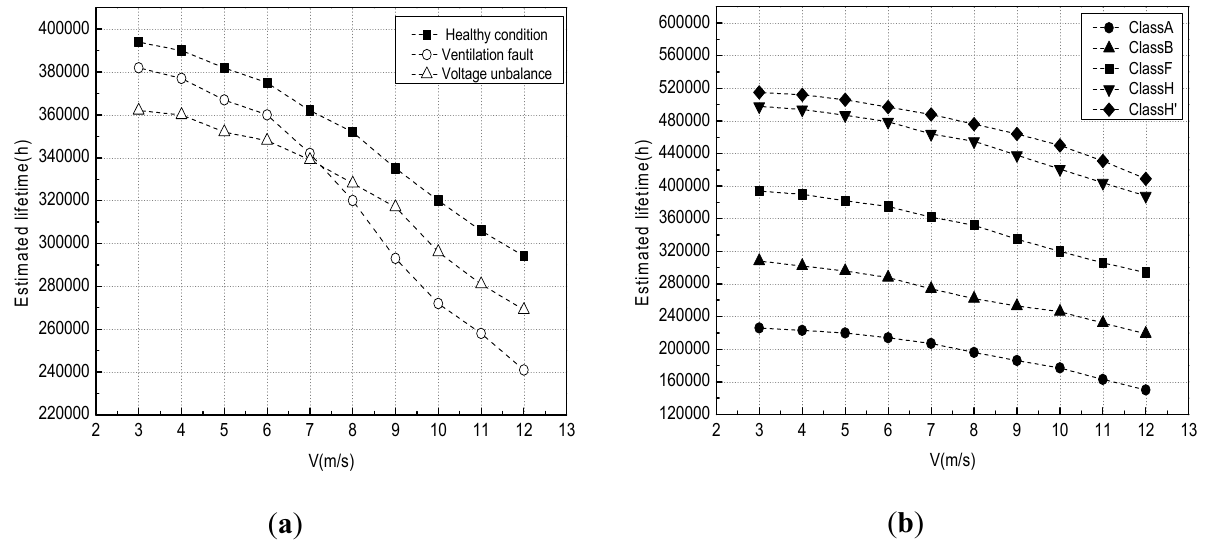
Figure 15. Lifetime downrating of stator windings subjected to generator system faults ( a ); lifetime estimation of stator windings with different Class ratings ( b